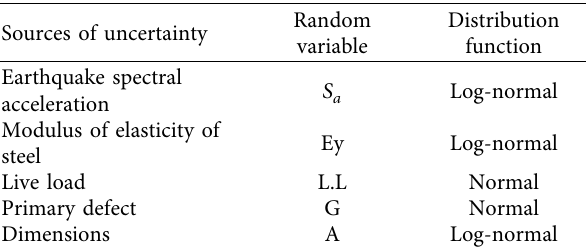
Figure 4: A number of section buckling modes in CUFSM software. Table 1: Sources of structural uncertainty.